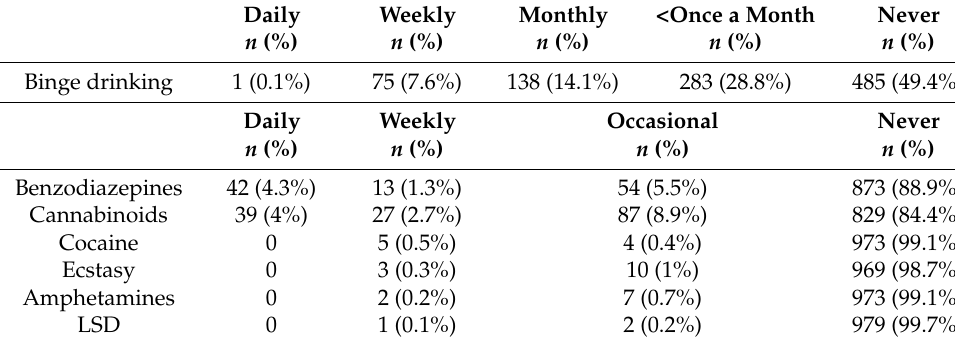
Table 2. Frequency of binge drinking and last 30 days’ use by drug type ( n =